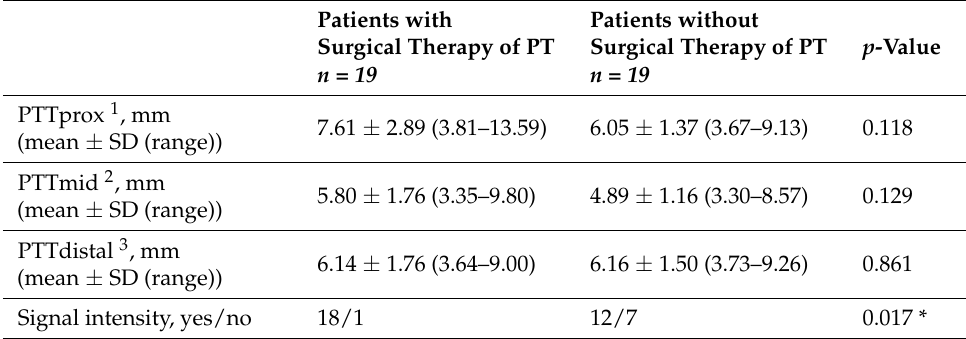
Table 4. Comparison of patellar tendon thickness (PTT) and signal intensity in the MRI of patients with and without surgical therapy of PT. Patients Patients with Surgical Therapy of PT n = 19